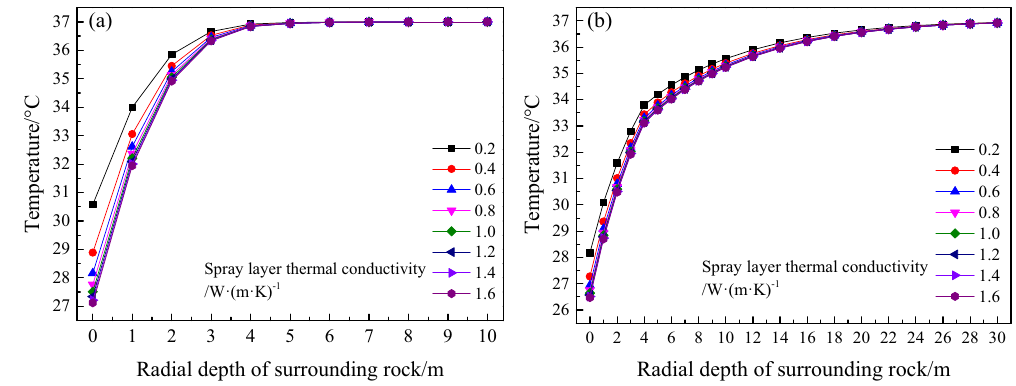
Figure 16: Influence of spray layer thermal conductivity on the surrounding rock temperature field: ( a ) 30 days; ( b ) 1,095